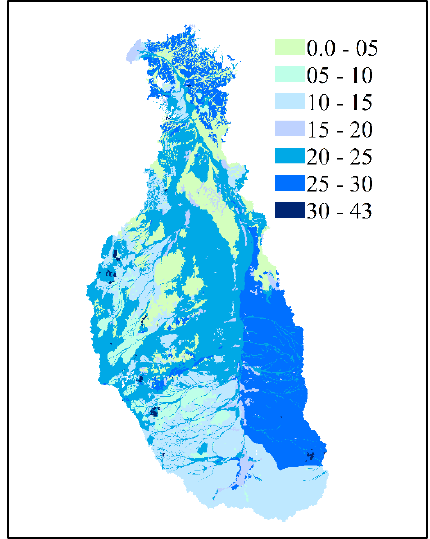
Figure 5. Catchment’s map of runoff values